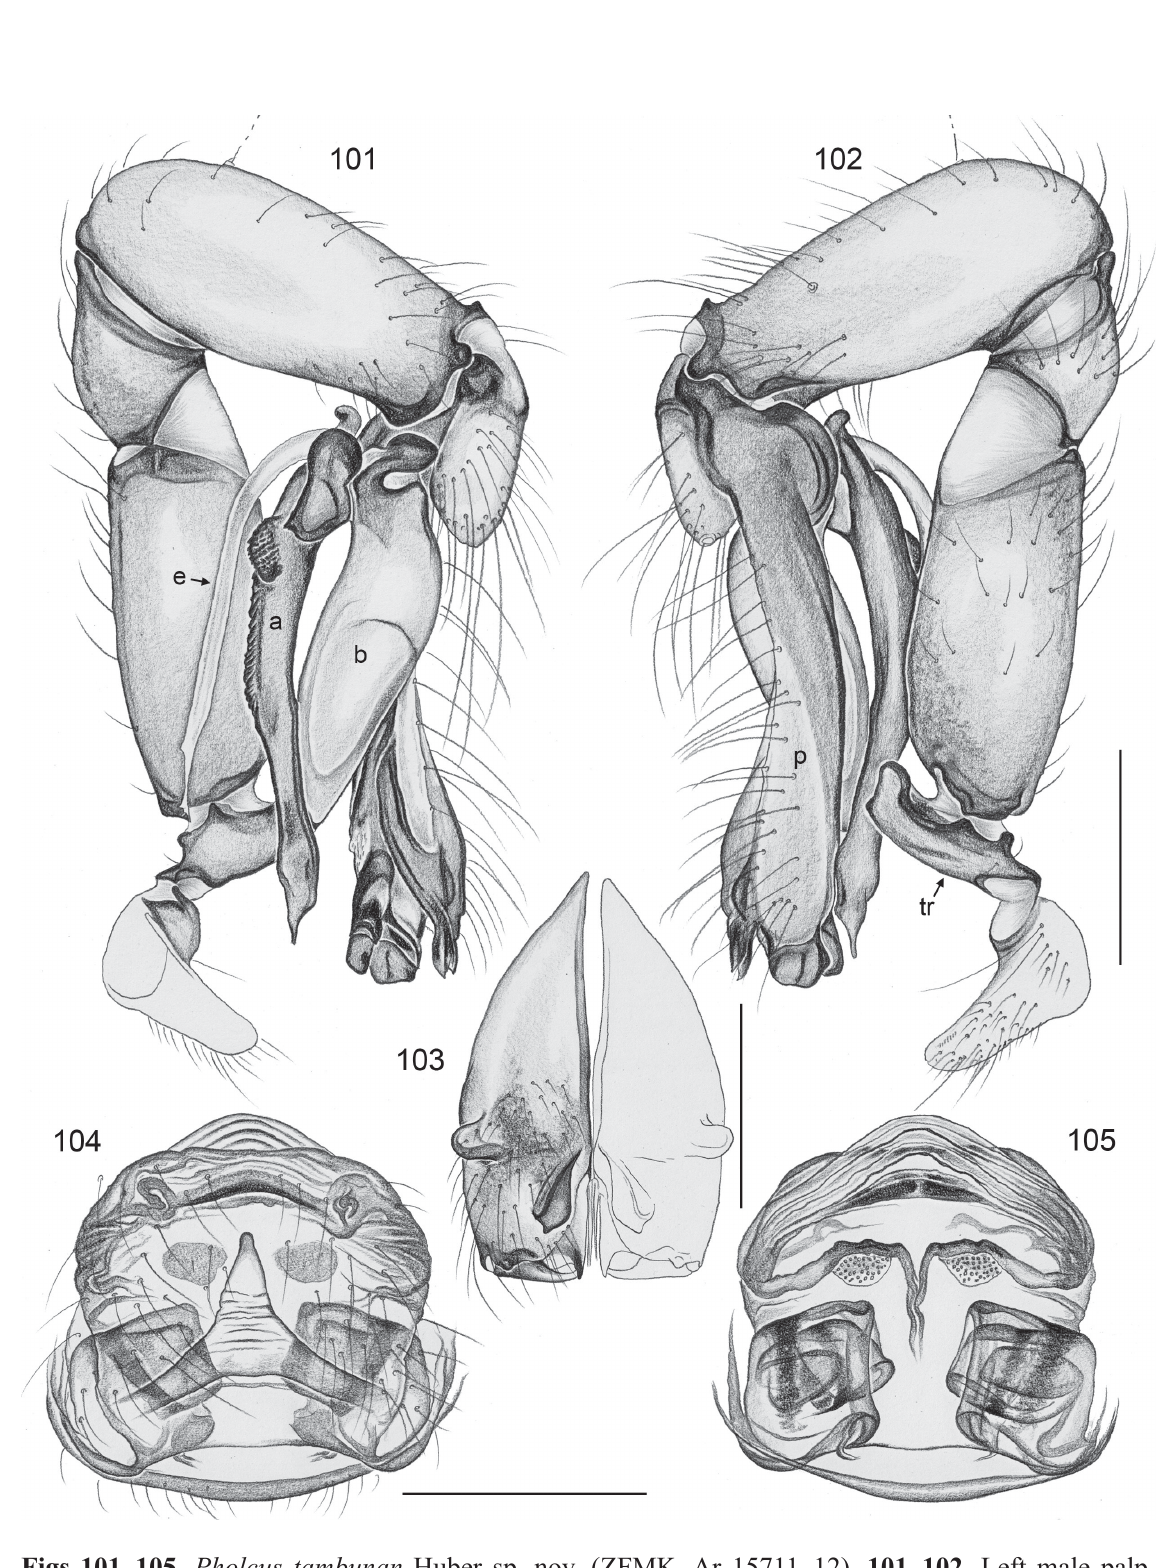
Figs 101–105. Pholcus tambunan Huber sp. nov. (ZFMK, Ar 15711–12). 101–102 . Left male palp, prolateral and retrolateral views. 103 . Male chelicerae, frontal view. 104–105 . Cleared female genitalia, ventral and dorsal views. Scale bars: 101–102, 104–105 = 0.5 mm; 103 =